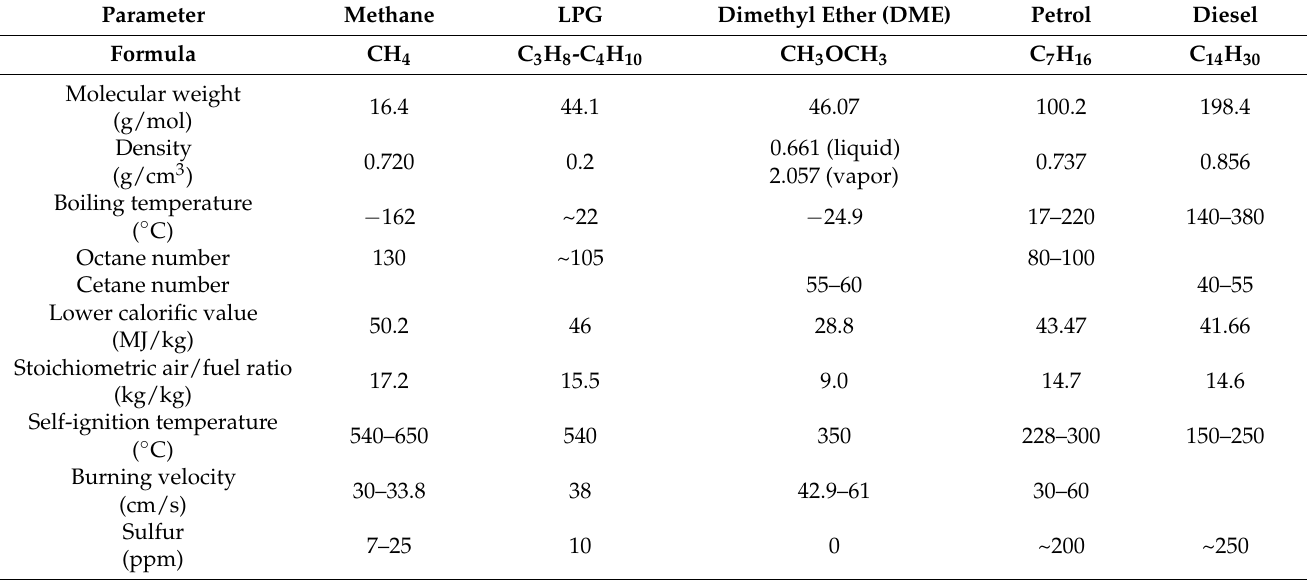
Table 1. Physicochemical properties of chosen fuels